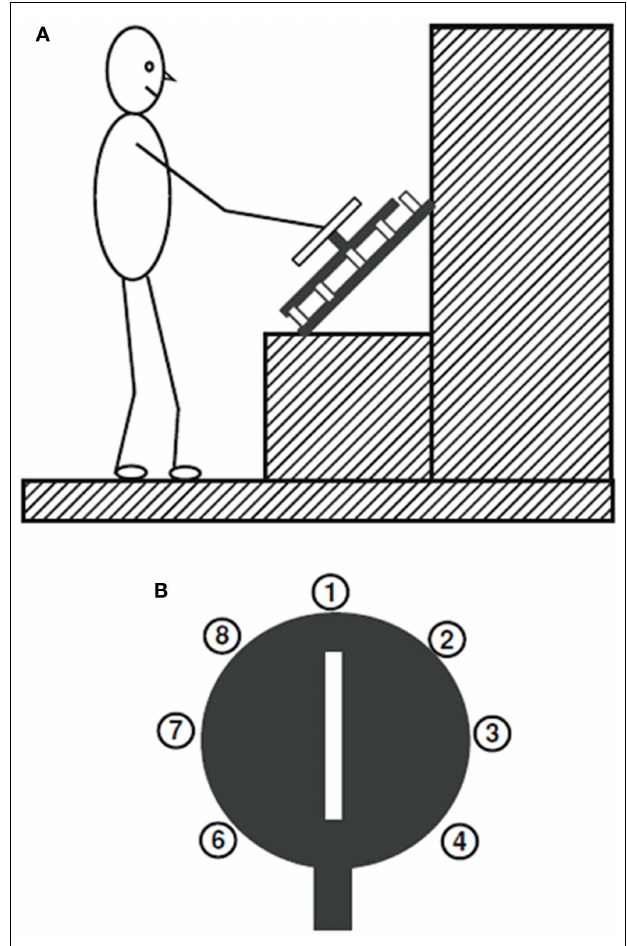
FIGURE 4 | Rotation task studied by Rosenbaum et al. (1993) . In (A) , a participant stands in front of the wheel, which is oriented at a 45˚ angle, after reaching out and grasping the handle. In (B) , the numbered end locations for the tab (bottom) are depicted for all possible targets, except for 5, which is hidden by the tab. (Image from Rosenbaum et al., 2006a.)